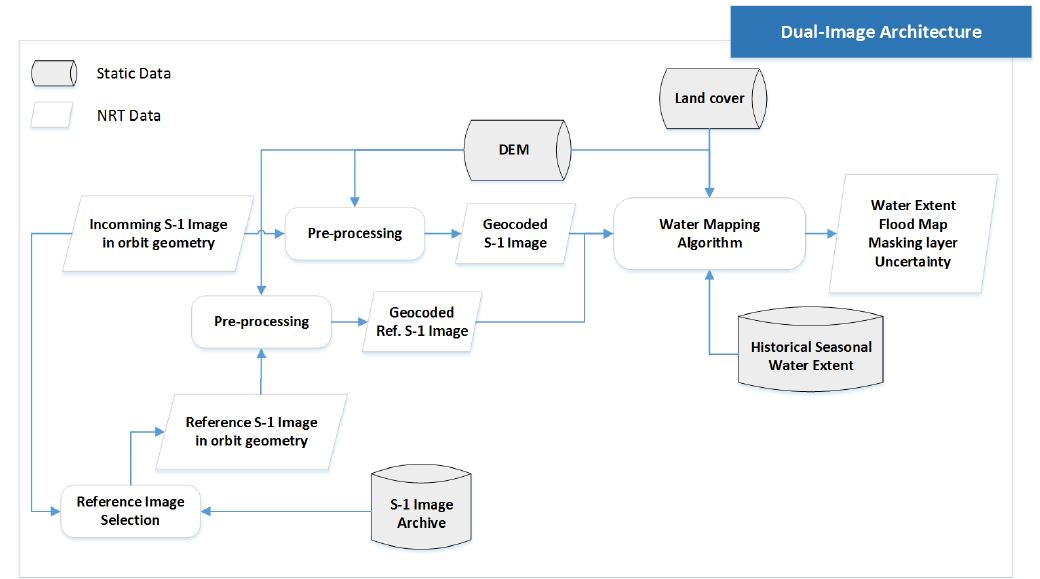
Figure 3. Dual-image processing architecture for global flood monitoring using Sentinel-1 SAR image data, based on change detection approaches using individual historic Sentinel-1 images as a